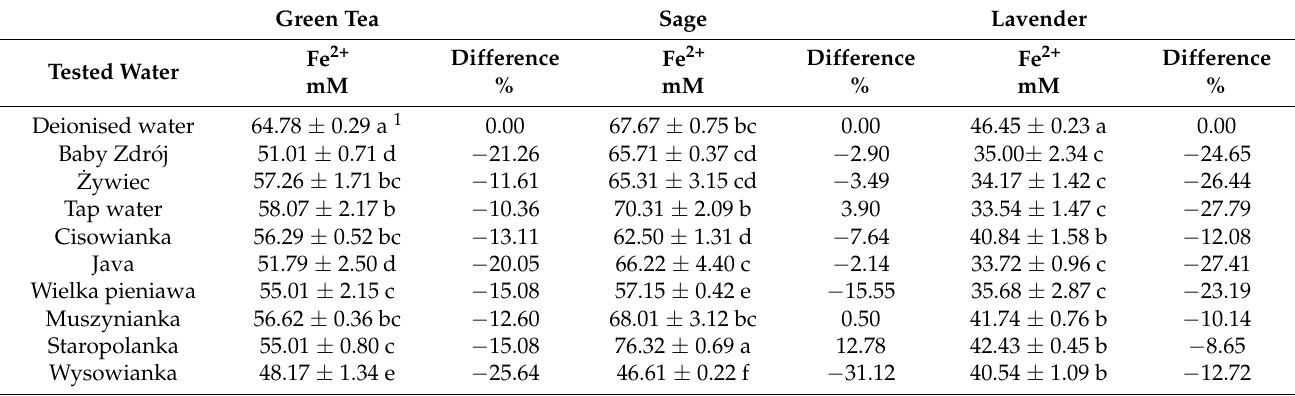
Table 5. Percentage decrease of Ferric Reducing Antioxidant Power (FRAP) (converted to mM Fe 2+ ) of green tea, sage and lavender brews prepared with the use of mineral waters relative to the brew prepared with the use of deionized water. Green Tea Sage Lavender Tested